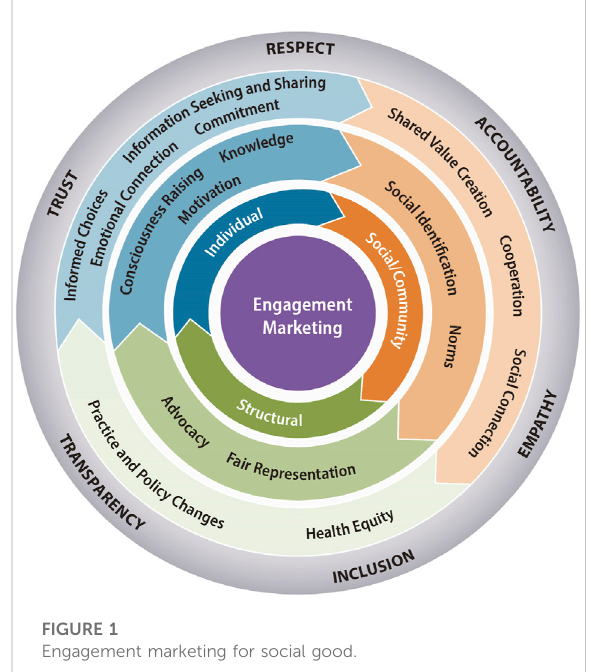
FIGURE 1 Engagement marketing for social